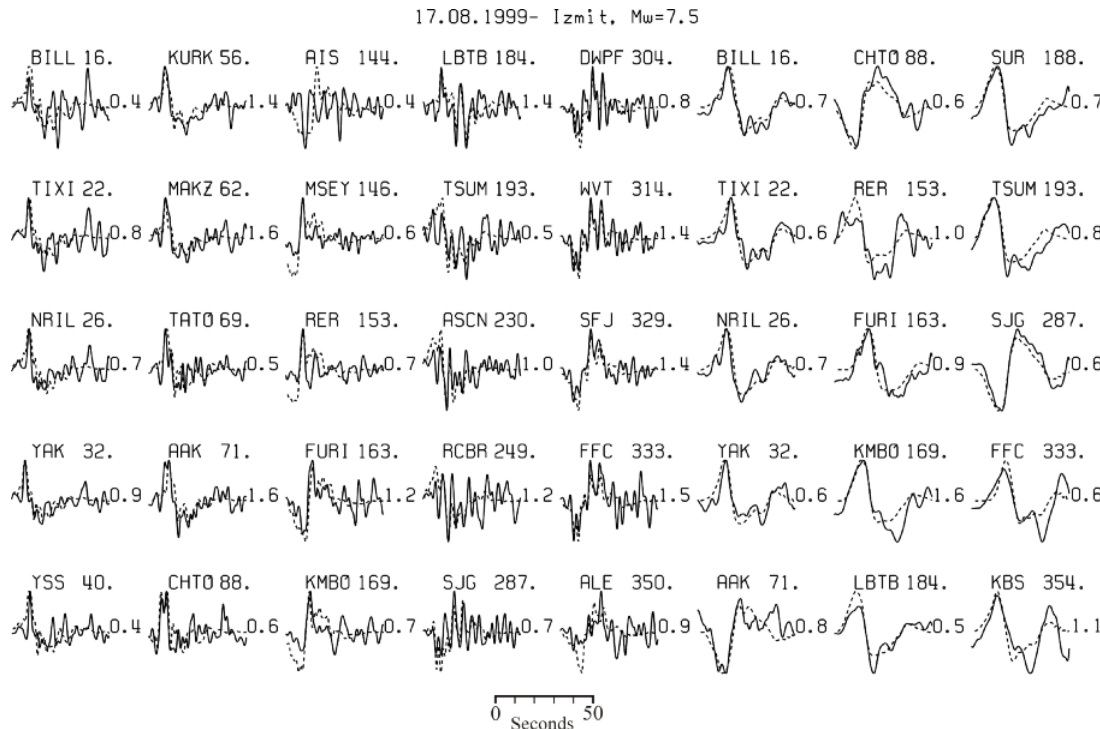
! Figure 7. Comparisons of the observed waveforms (solid curves) and the synthetic waveforms (dashed curves) calculated for the slip model shown in Figure 6a. The station names and azimuths, clockwise from the North, are given on the top left and top right of each observed–synthetic waveform pair, respectively. The numbers to the right of each waveform pair indicate the synthetic-to-observed amplitude